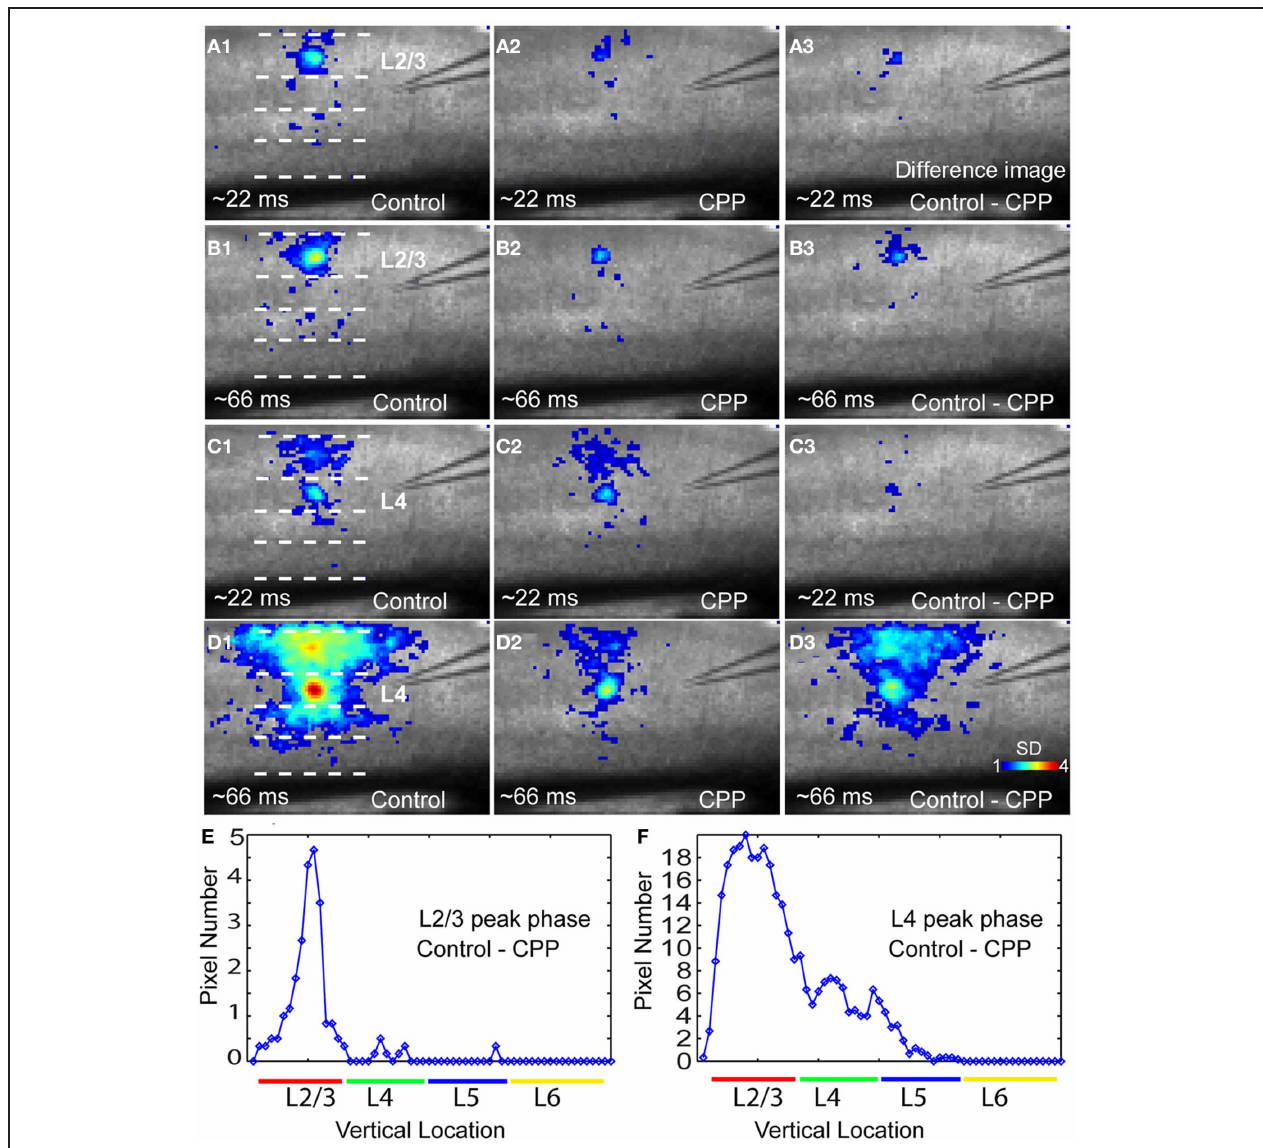
FIGURE 8 | The NMDA receptor antagonist CPP preferentially reduces peak activation of photostimulation-evoked VSD responses in a laminar-specific manner. (A1 and A2) are the averaged images across the initiation phase of VSD responses to photostimulation in layer 2/3 in normal ACSF and CPP, respectively. (A3) is the difference image between (A1 and A2) . In these images, only the pixels with amplitudes ≥ 1 SD are plotted. (B1 and B2) are the averaged images across the peak phase of VSD responses to photostimulation in layer 2/3 in normal ACSF and CPP, respectively. (B3) is the difference image between (B1 and B2) . (C1 and C2)